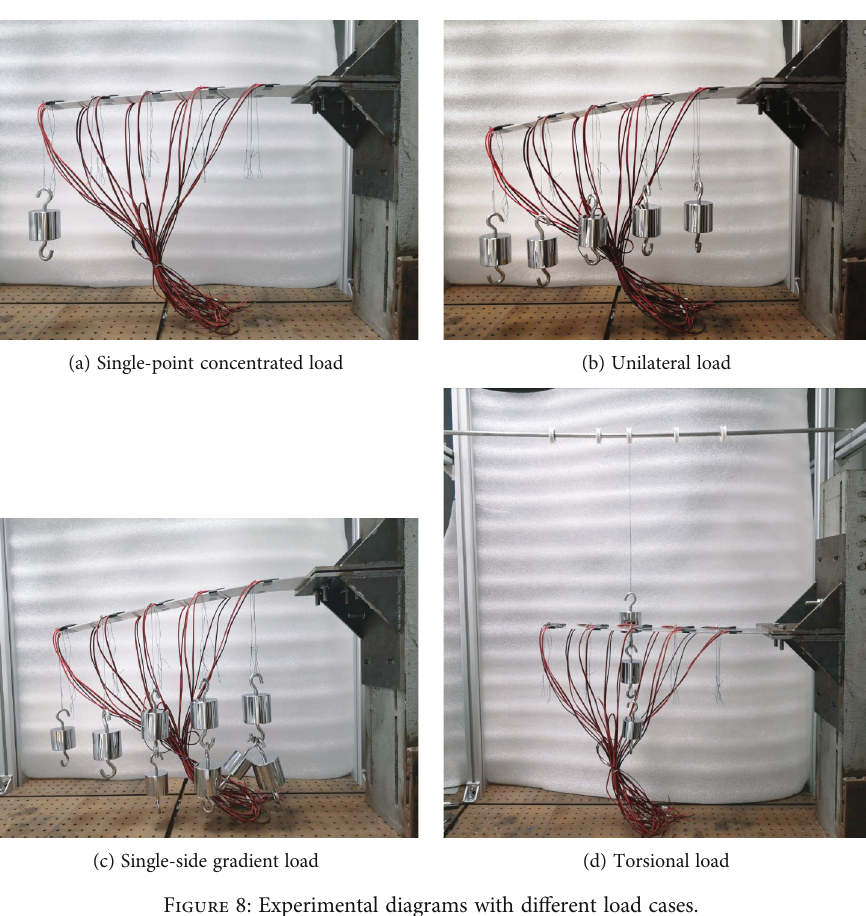
Figure 8: Experimental diagrams with di ff erent load cases.